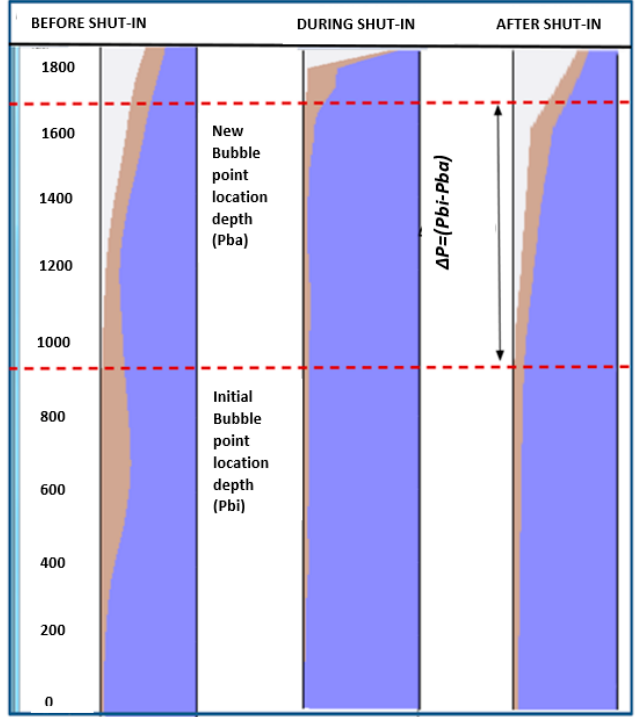
Figure 2. Bubble point location depths before and after closing the well head wing valve.